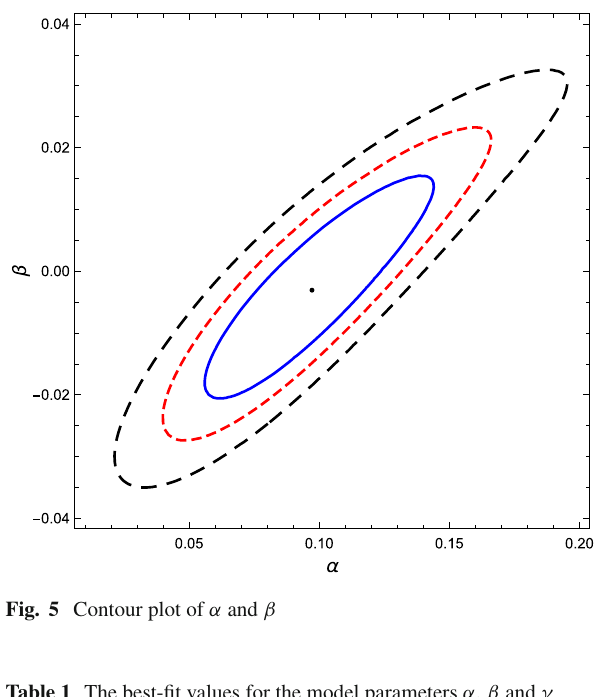
Fig. 5 Contour plot of α and β